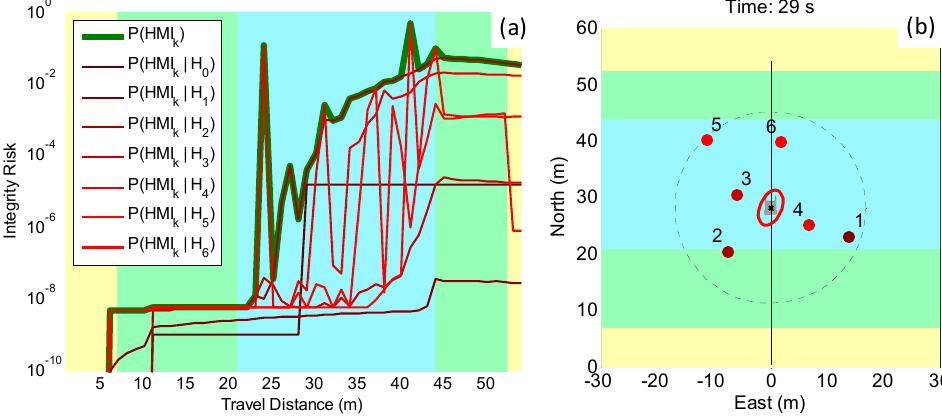
Figure 4. Simulation results accounting for UOs. ( a ) P ( HMI k )-bound contributions under each UO hypothesis ( H 0 assumes no UO, H 1 assumes a UO masks landmark “1”, etc.): the overall risk is the thick green line. ( b ) Color-coded landmark geometry: the color code identifies which landmark is masked by a UO under the corresponding hypothesis in the left-hand-side plot.